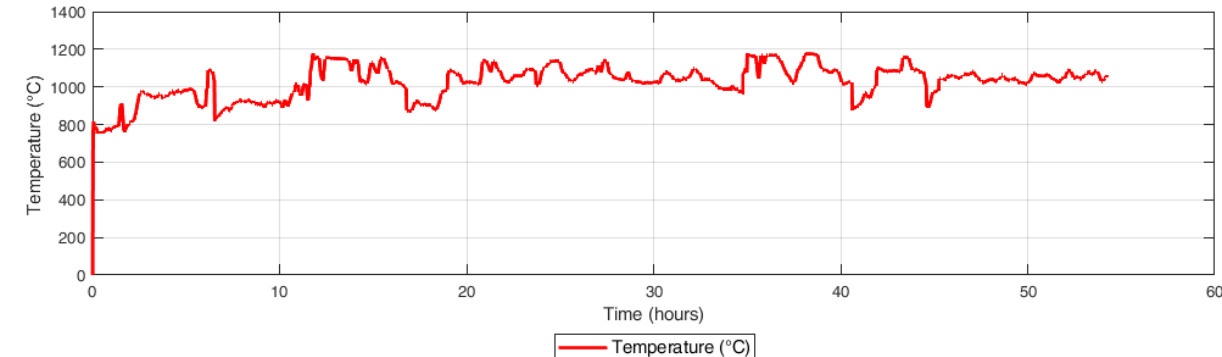
Figure 29. Optimized manipulation variables during MPC [41].